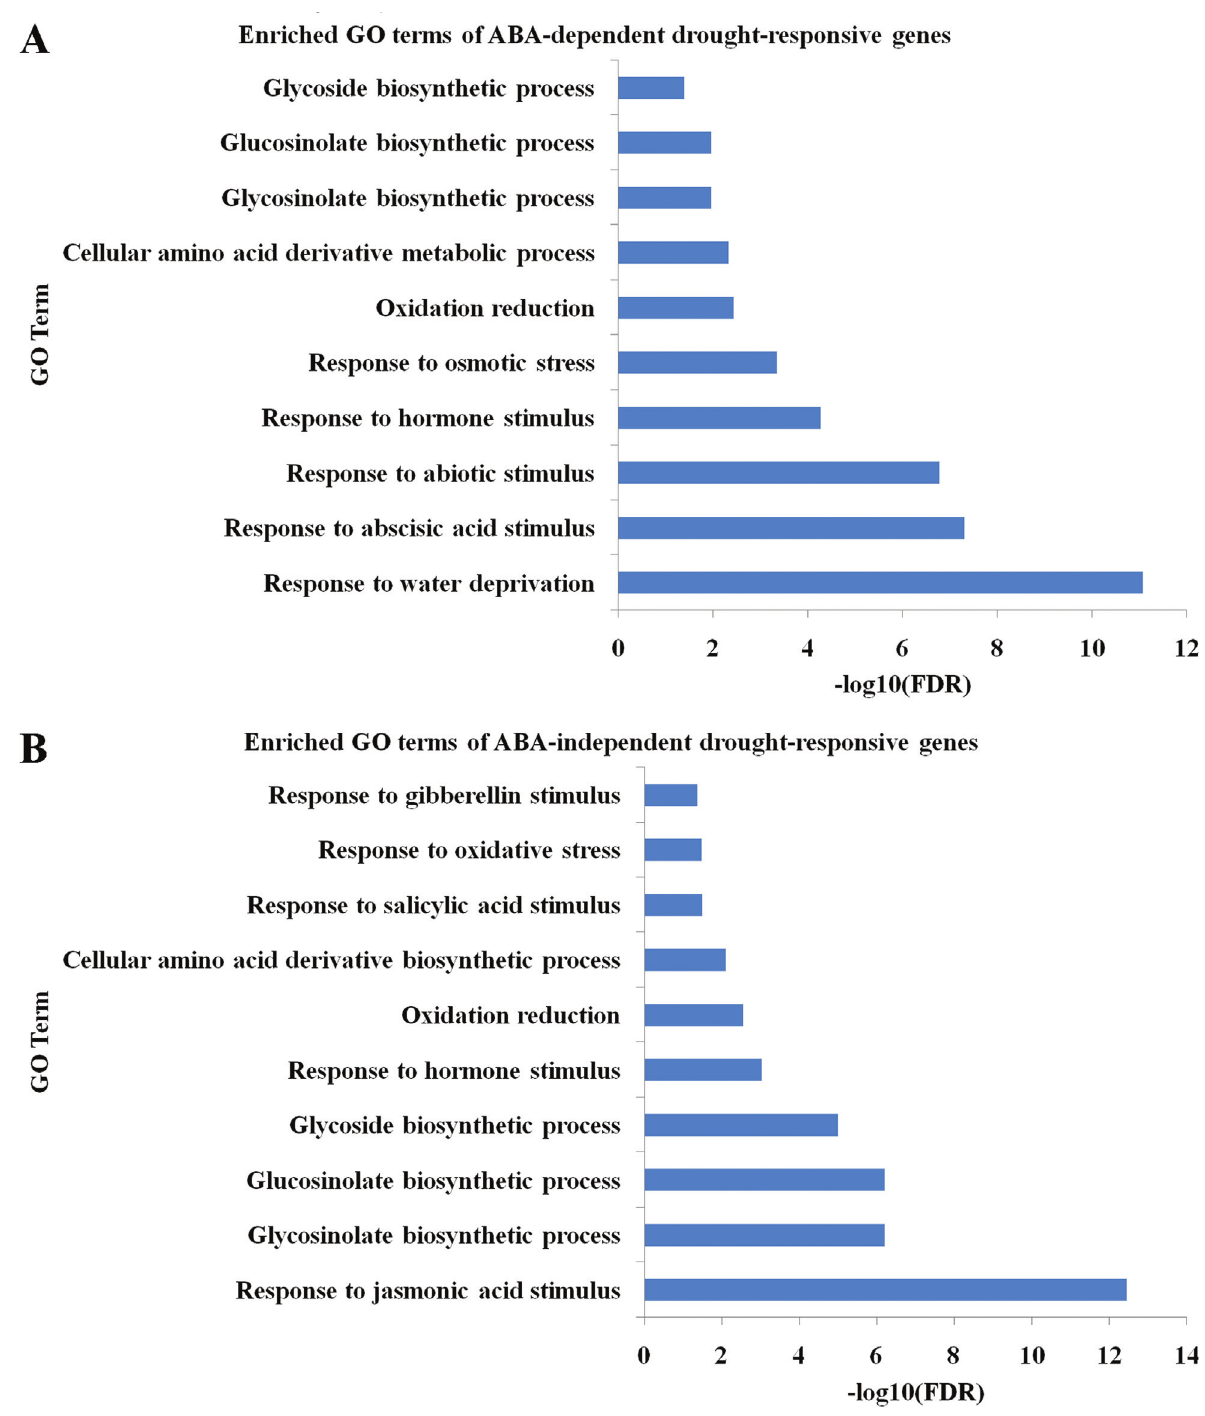
Figure 2 - Functional enrichment of (A) ABA-dependent and (B) ABA-independent drought-responsive genes. The x-axis represents the negative log 10 (FDR) of enriched GO terms. The y-axis represents the GO